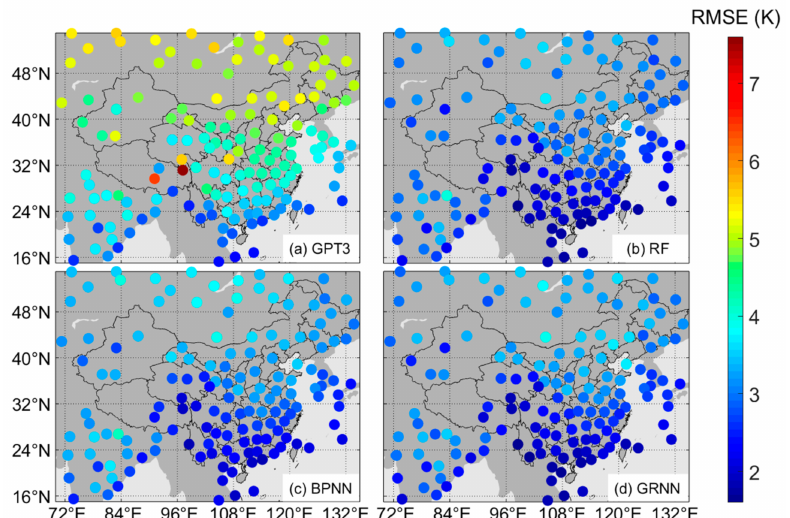
Figure 7. Spatial distribution of the root mean square errors (RMSEs) at each radiosonde station for ( a ) GPT3 (global pressure and temperature model 3), ( b ) RF (random forest), ( c ) BPNN (backpropagation neural network), and ( d ) GRNN (generalized regression neural network).